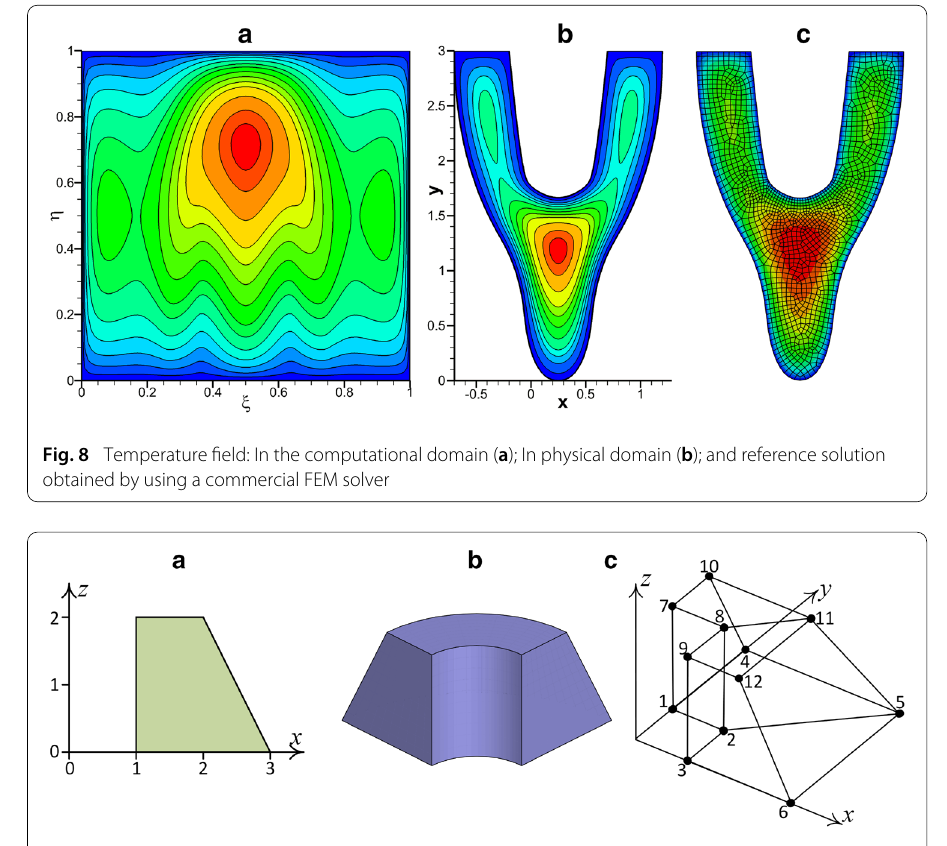
Fig. 9 Domain geometry: Dimensions of the generative surface ( a ); the resulting volume ( b ); and the control net for the NURBS representation ( c